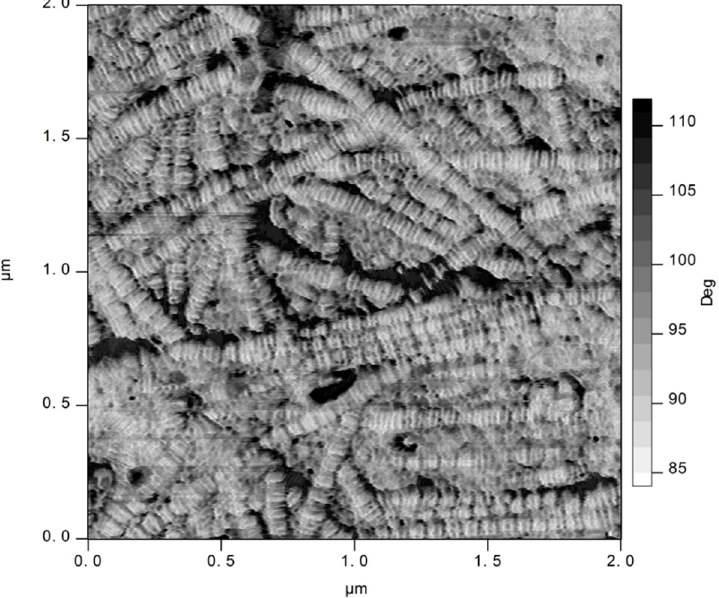
Figure 4. AFM image of the bovine amnion taken on the inner (fetal) surface. A phase image, representing the shift in phase of the oscillating AFM cantilever as it interacts with the sample (magnification ×37,000).